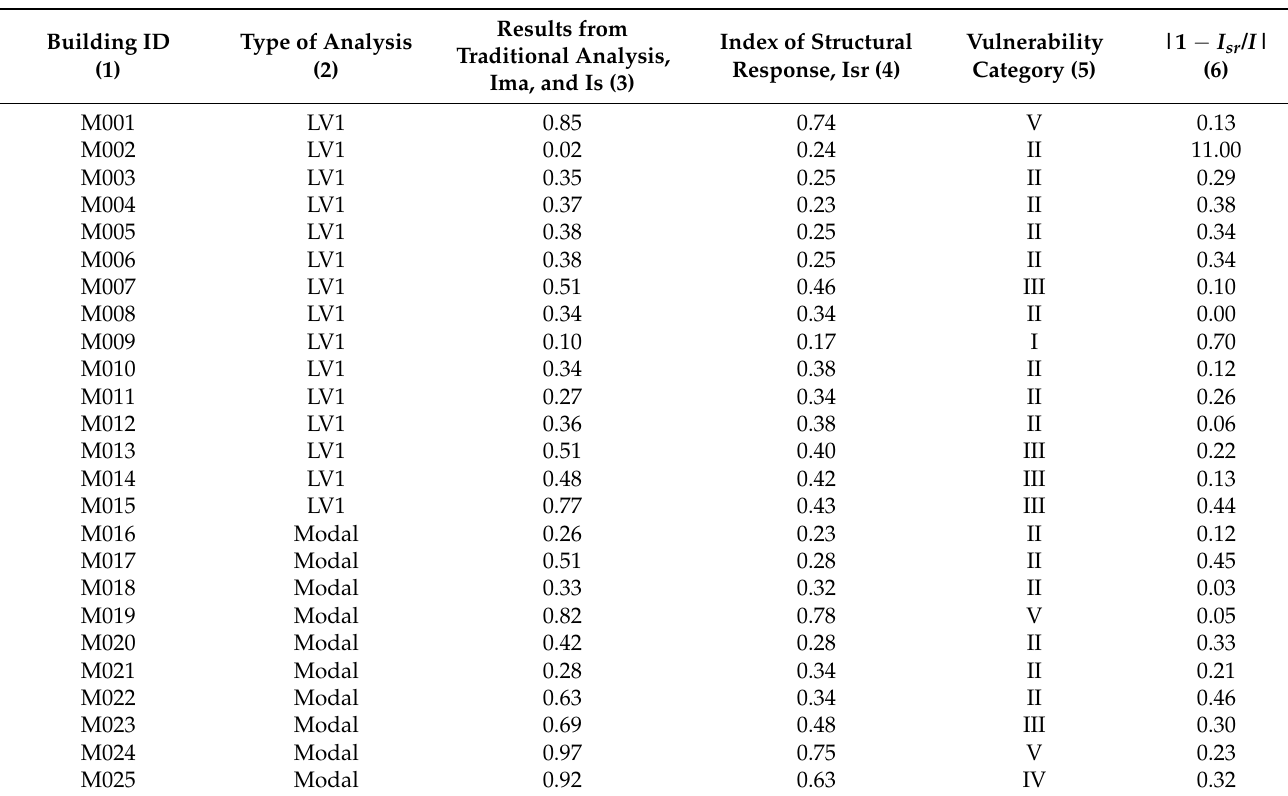
Table 11. Results of the validation—traditional vs. expeditious